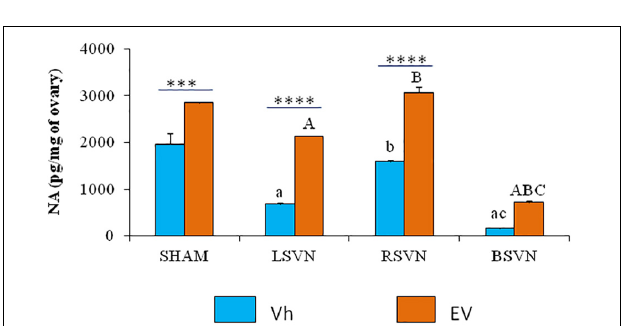
FIGURE 3 | Noradrenaline concentration in the celiac superior mesenteric ganglia (CSMG). Mean ± SEM noradrenaline concentrations in the CSMG of rats treated with vehicle (Vh) or EV at day 10 of life, with sham-surgery (sham) or unilateral (LVNS or RVNS) or bilateral (BVNS) vagotomy at day 76 of life, and sacrificed at day 80–82 of life. A vs. EV-Sham, two-way ANOVA followed by Tukey´s multiple comparisons test. The line indicates the difference between groups ∗∗ p < 0.01, Student’s t -test.